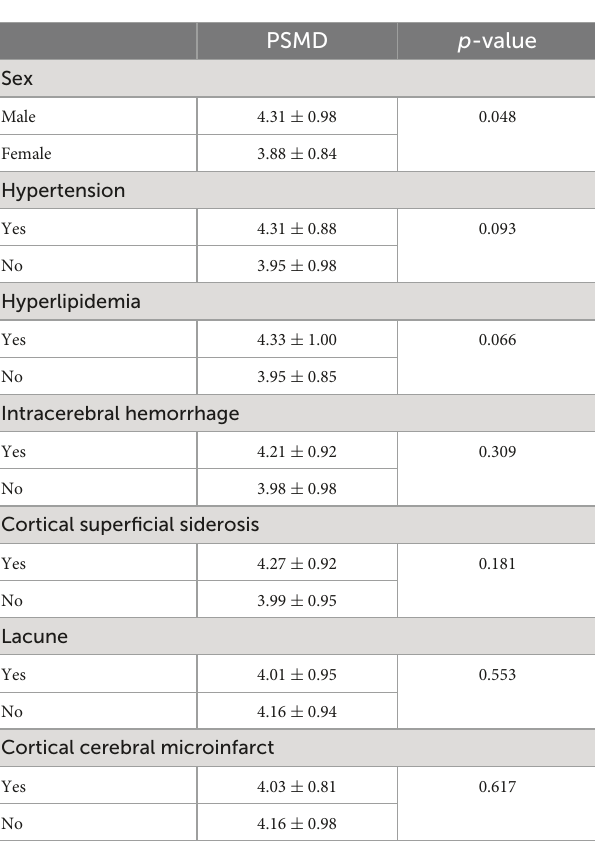
TABLE 2 The relationship between peak width of skeletonized mean diffusivity (PSMD) and categorical variables, including demographics, vascular risk factors, and imaging markers in patients with cerebral amyloid angiopathy.